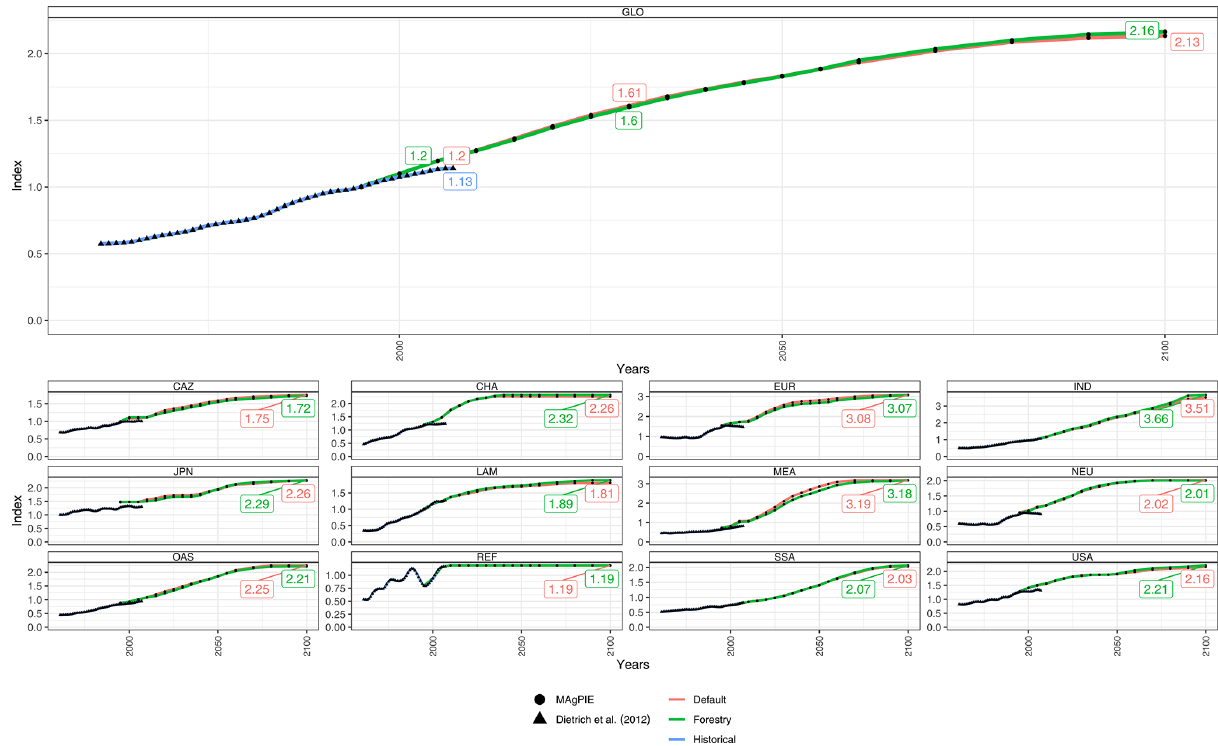
Figure A3. Global (upper panel) and regional (bottom panel) land-use intensity indicator ( τ ) as a productivity measure (index).